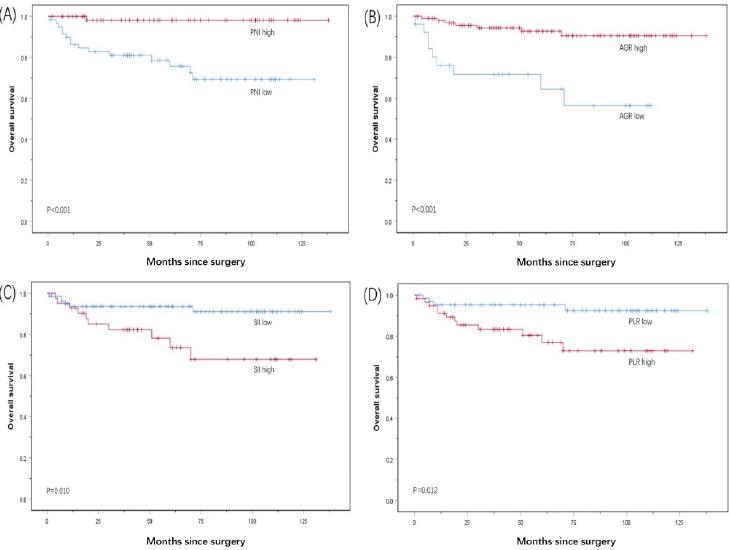
Figure 2. Kaplan–Meier survival curves for OS according to ( A ) PNI, ( B ) AGR, ( C ) Sll, and ( D ) PLR in PC patients.